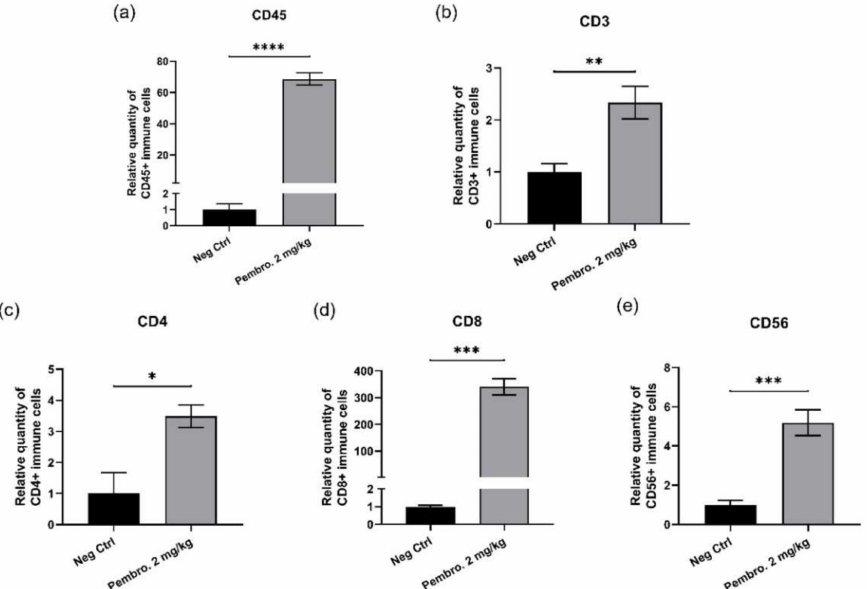
Figure 8. Relative mRNA expression levels of chicken immune markers (mean values ± SEM) in in ovo xenografted H460 tumors after treatments with pembrolizumab. Significant up-regulation was found for all detected genes: ( a ) CD45, up-regulated 68.5 times ( p < 0.0001, ****); ( b ) CD3, up-regulated 2.3 times ( p = 0.0062, **); ( c ) CD4, up-regulated 3.5 times ( p = 0.0124, *); ( d ) CD8, up-regulated 340 times ( p = 0.0001, ***); ( e ) CD56, up-regulated 5.2 times ( p = 0.0008,